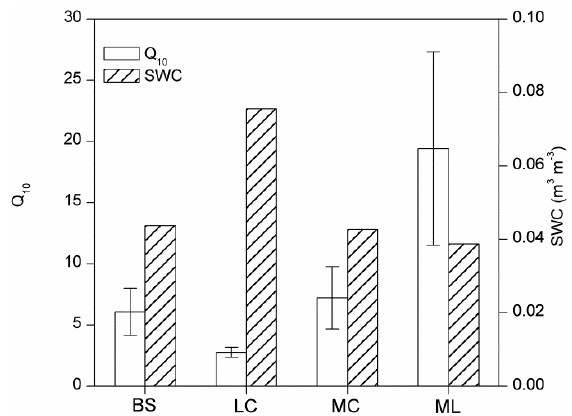
Figure 4. Q 10 values calculated from the whole winter with corresponding mean SWC values for four microsites including bare surface (BS), lichen crust (LC), moss crust (MC), and mixed crust of both moss and lichen (ML). Error bars are the 95% confident intervals (CIs) derived from the Q 10 function.